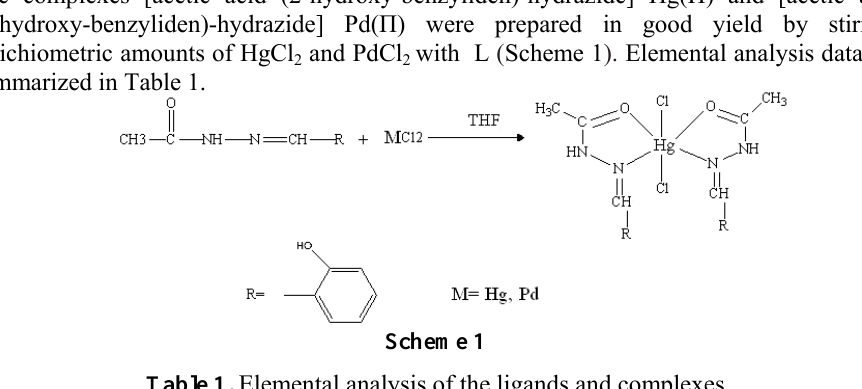
Table 1. Elemental analysis of the ligands and complexes